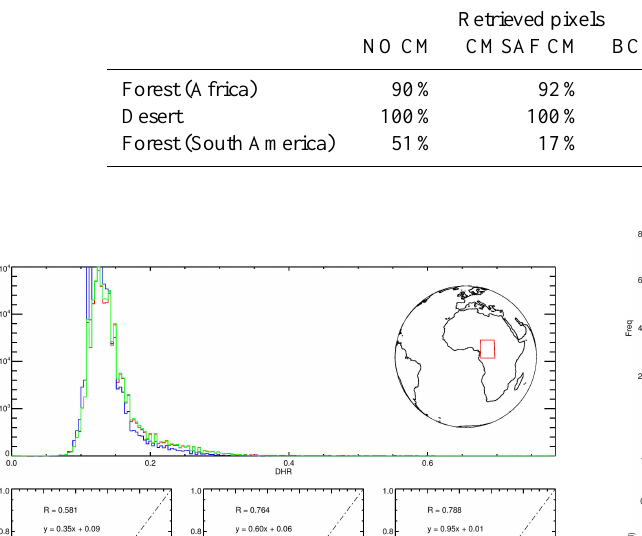
Table 4. Impact of a cloud mask applied to the MSA processing on the number of retrieved pixels (total higher than a threshold of 0.4).